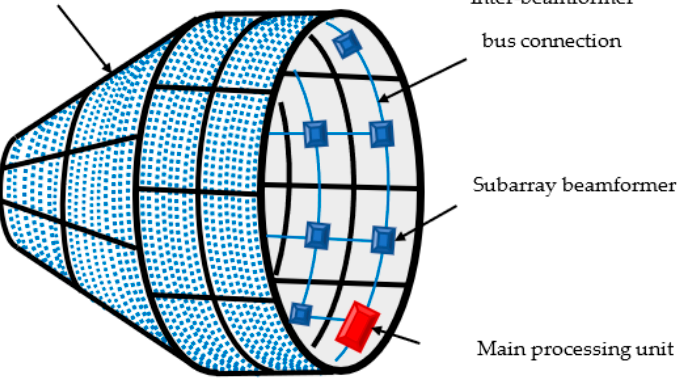
4 array and beamforming